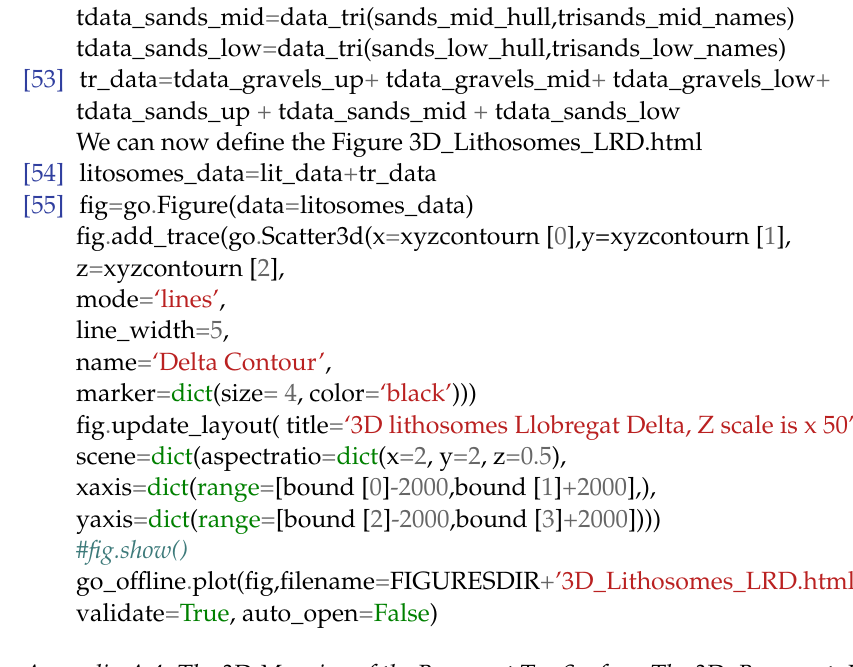
fig.add_trace(go.Scatter3d(x=xyzcontourn [0],y=xyzcontourn [1],